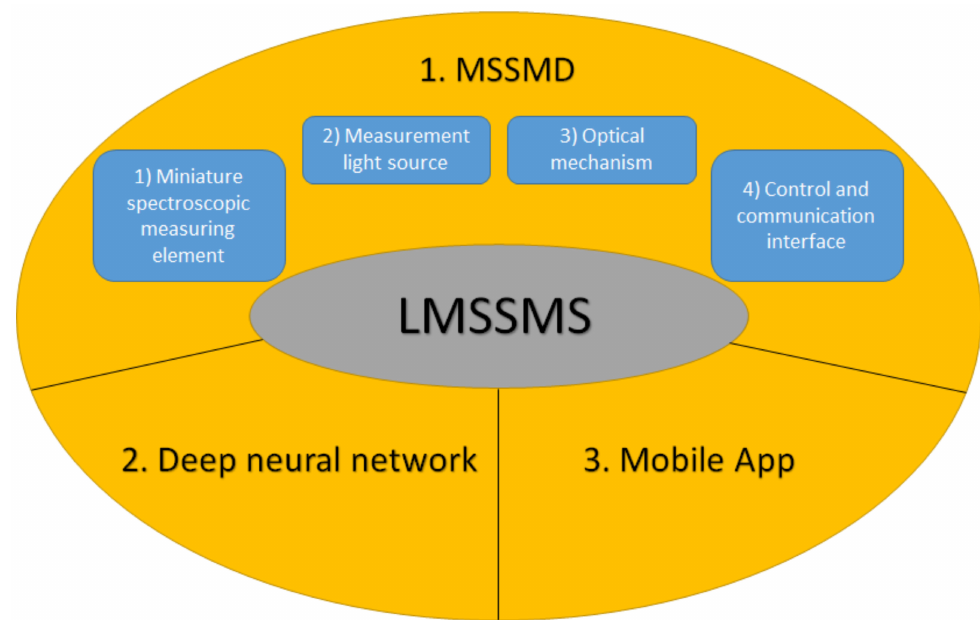
Figure 1. The structure of the developed